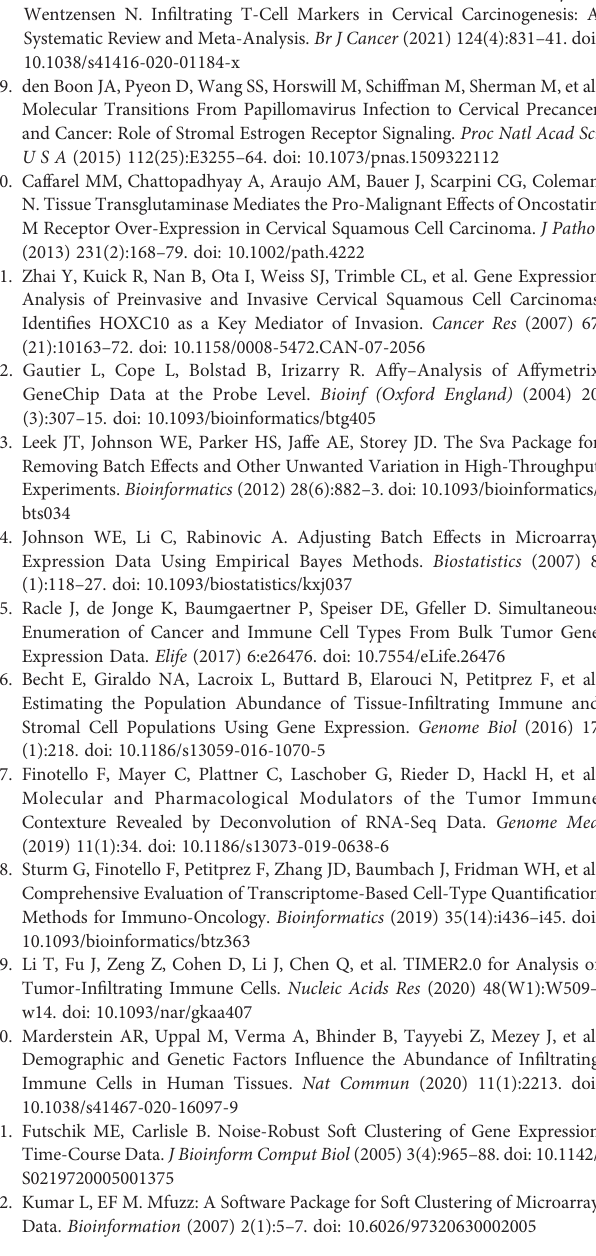
Supplementary Figure 1 | Correlation matrices of methods. Heatmap displaying Spearman correlations of seven computational methods for the CD4 + (left bottom) and CD8 + (right top) T cells abundance in (A) normal, (B) LSIL, (C) HSIL and (D) SCC. Supplementary Figure 2 | The in fi ltration patterns of selected microenvironment cells estimated by seven methods. Line plots showing the abundance of selected microenvironment cells (mean ± SEM) changes over disease stages. Supplementary Table 1 | A collection of studies used as a reference for correction of cell in fi ltration patterns. Supplementary Table 2 | Normalized abundance scores of